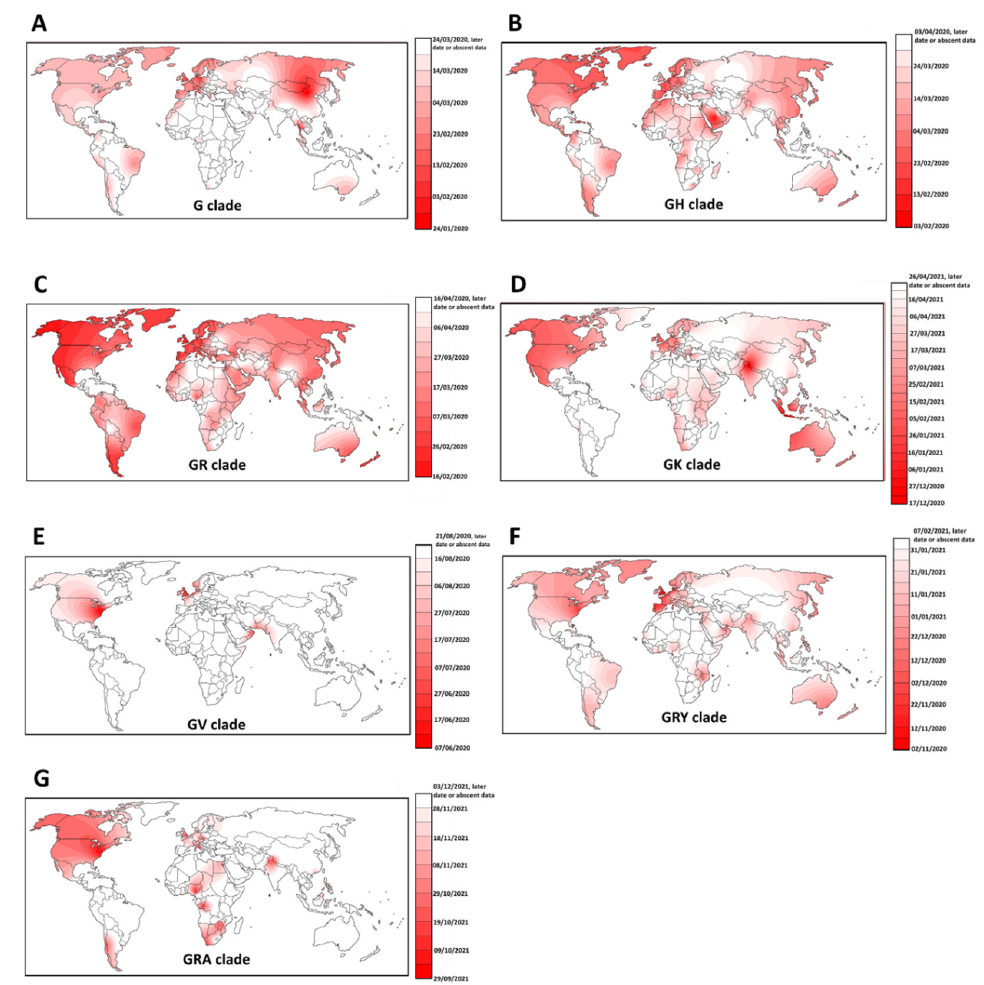
Figure 6. Geographic interpolation results of the first appearance of global clades as deposited in GISAID using the Kriging algorithm. Results were obtained for clades G ( A ), GH ( B ), GR ( C ), GK ( D ), GV ( E ), GRY ( F ) and GRA ( G ).